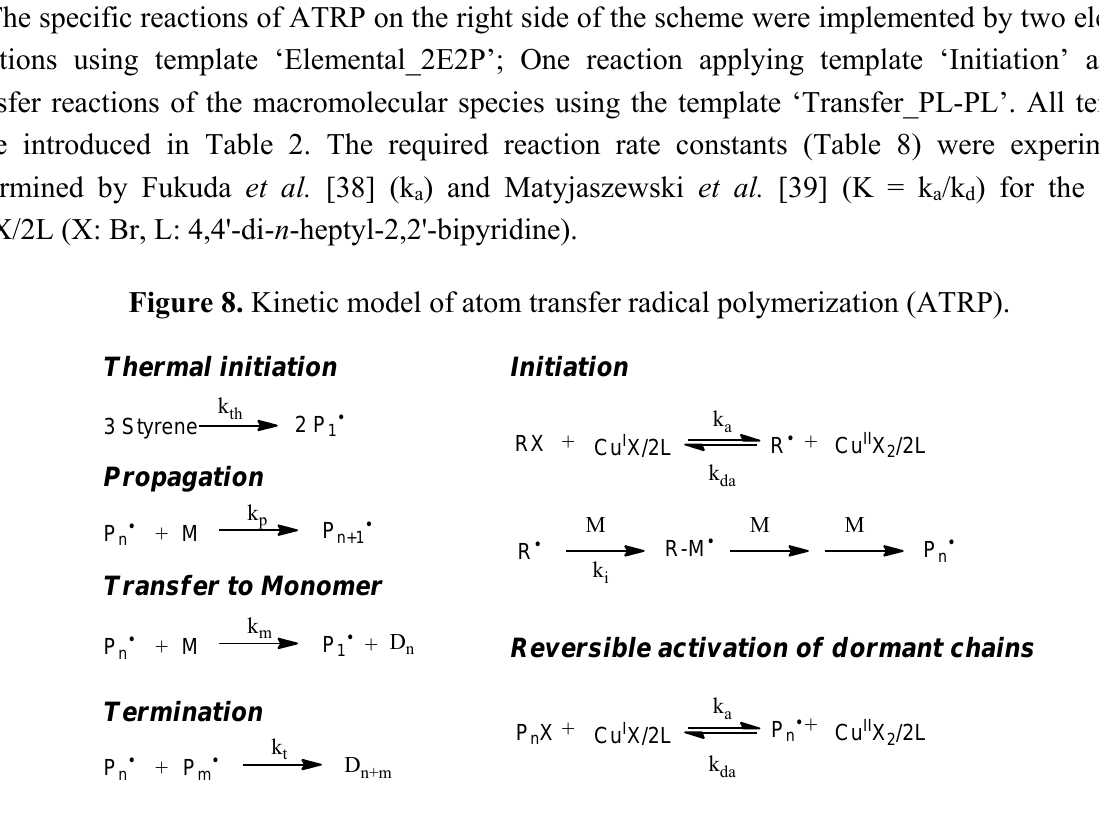
Table 8. Rate constants concerning reversible activation of dormant chains at 110